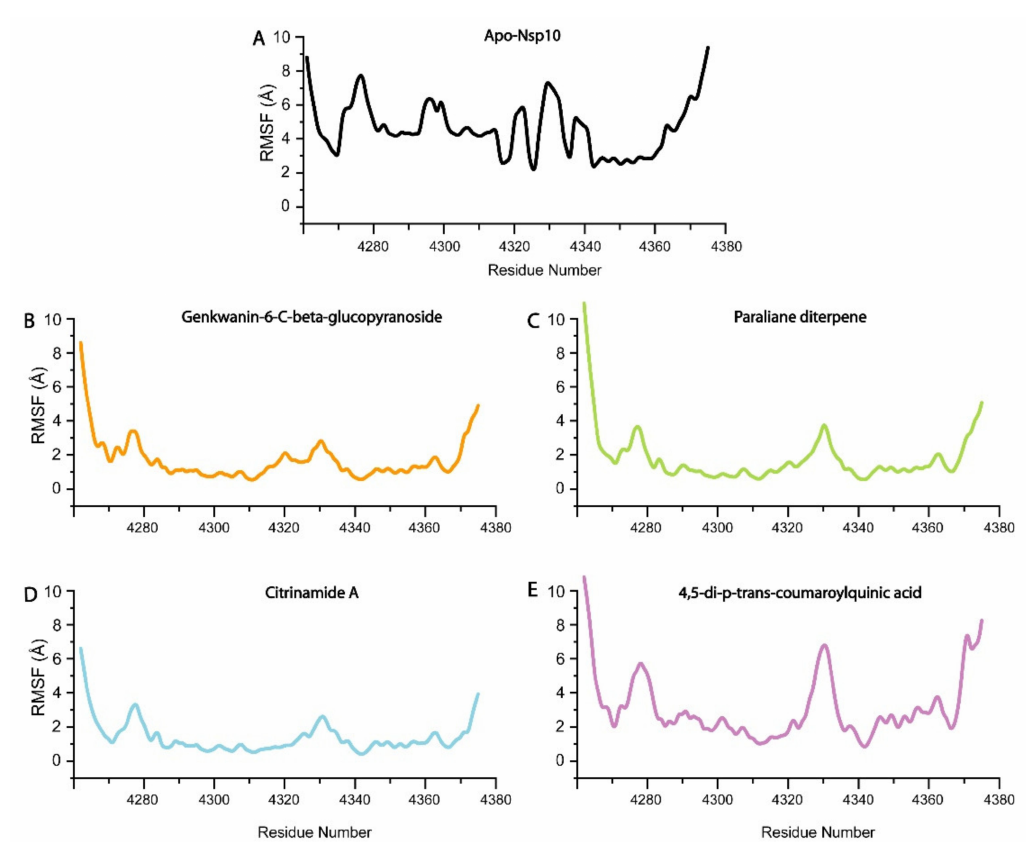
Figure 4. Root mean square fluctuations (RMSF) of all four system ( A ) nsp10-apo, ( B ) Genkwanin-6-C-beta-glucopyranoside- nsp10 complex, ( C ) Paraliane diterpene-nsp10 complex, ( D ) Citrinamide A, ( E ) 4,5-di-p-trans-coumaroylquinic acid. The x-axis shows the number of residues and the y-axis the RMSF in